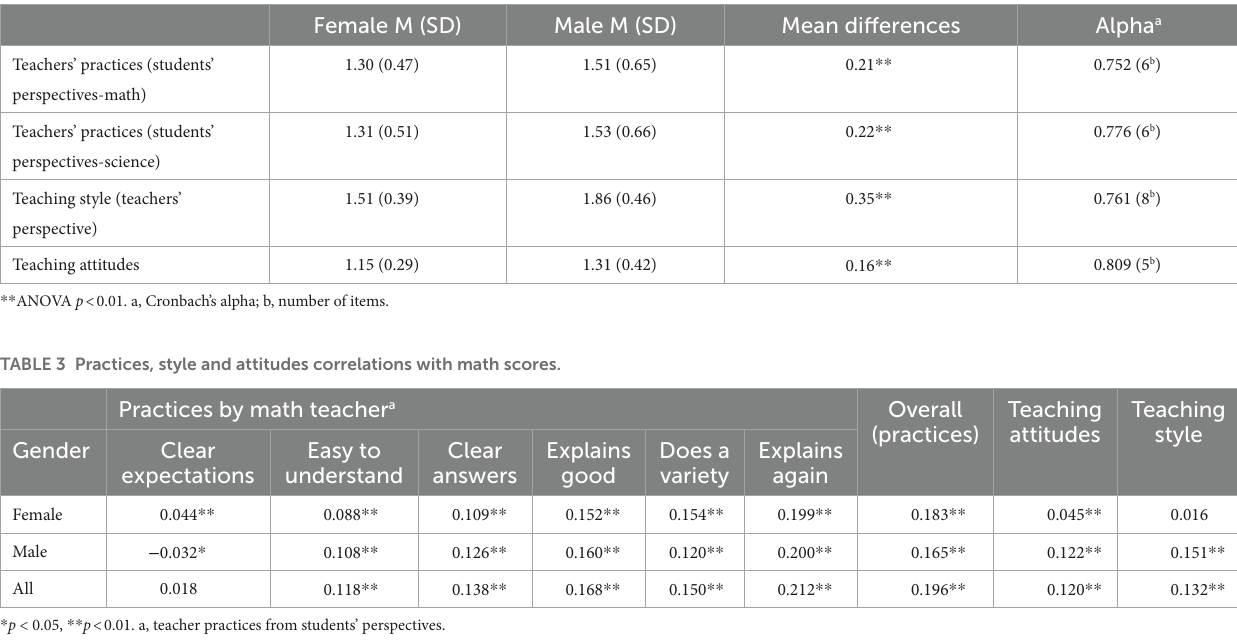
TABLE 2 Means, Cronbach’s alpha, and test of differences by gender.